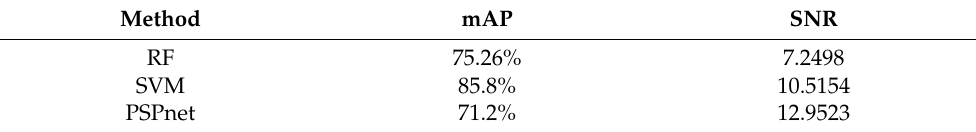
Table 5. Segmented image evaluation.